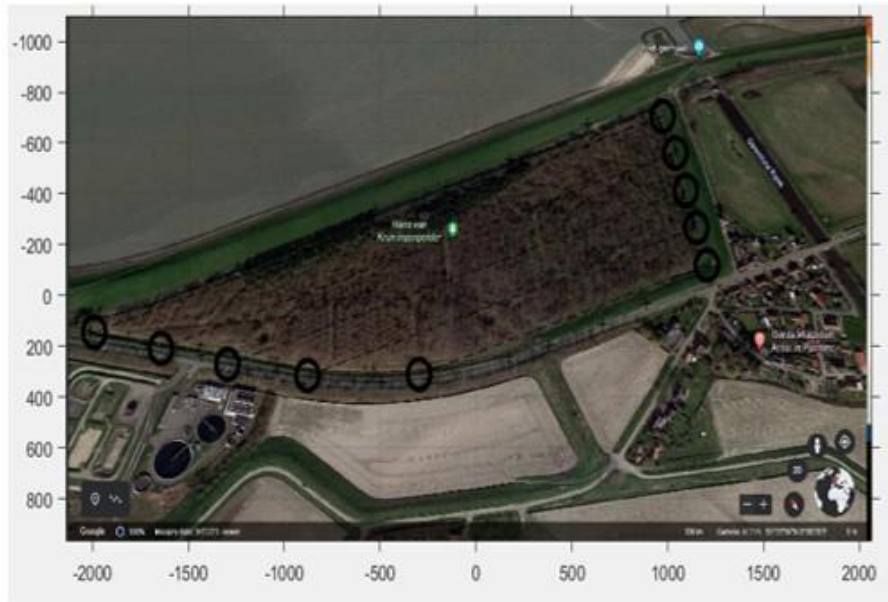
Figure 7. Carved out Map Region for Grazing Field.